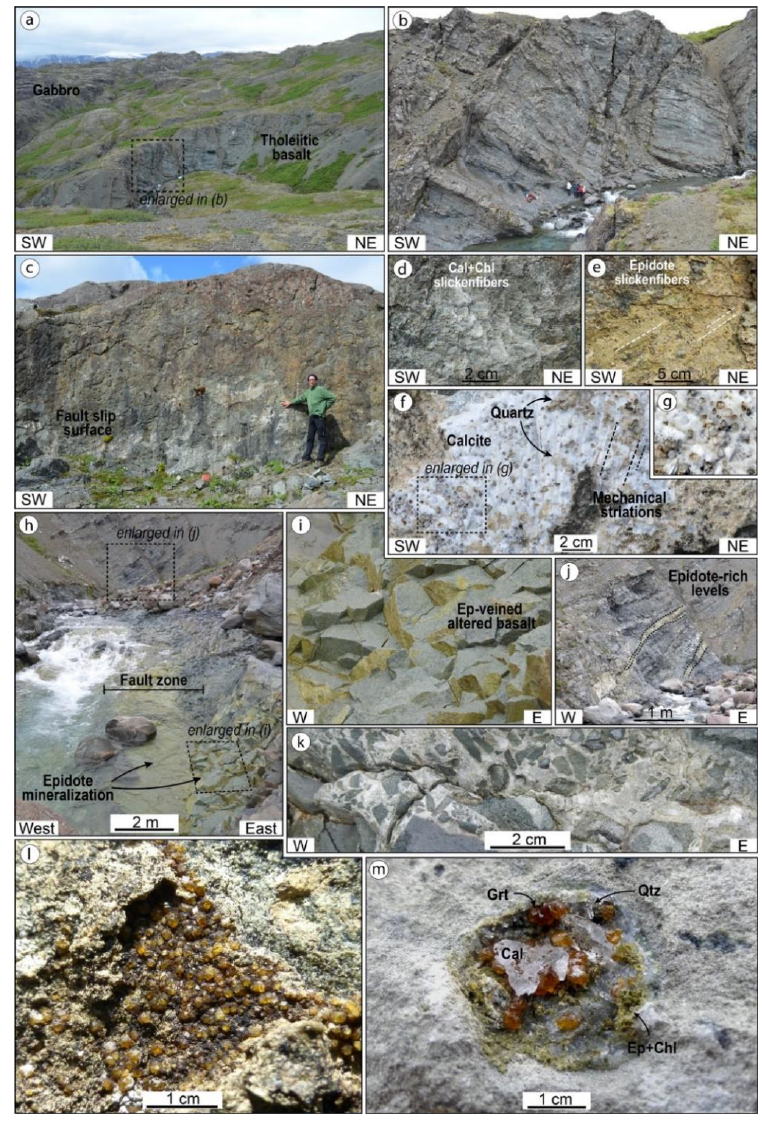
Figure 15. Photos of outcrops from the exhumed geothermal system of Geitafell (after Reference [13]): ( a ) panoramic view of the gabbro and host rocks; ( b ) panoramic view of a fault zone affecting the hosting rocks; ( c ) example a mineralized fault slip surface, in gabbro; ( d) –( e ) calcite, chlorite and epidote slickenfibers on slip surfaces with oblique-slip component, indicating syn-kinematic geothermal fluids circulation; ( f – g ) quartz and calcite mineralization associated to the subse- quent (normal) movement of the fault; ( h ) panoramic view of a mineralized (epidote and calcite) fault zone; ( i ) detail of epidote-altered basalt; ( j ) epidote-rich levels of vesicular basalt hydraulically connected with the fault zone shown in ( h ); ( k ) detail of mineralized hydraulic breccia developed along the fault zone; ( l ) porous basalt lava can host garnet crystals aggregate when hydraulically connected to the channeling fault zone; ( m ) detail of a vesicle characterizing basalt made up of hydrothermal minerals. Mineral abbreviation from Reference [70].